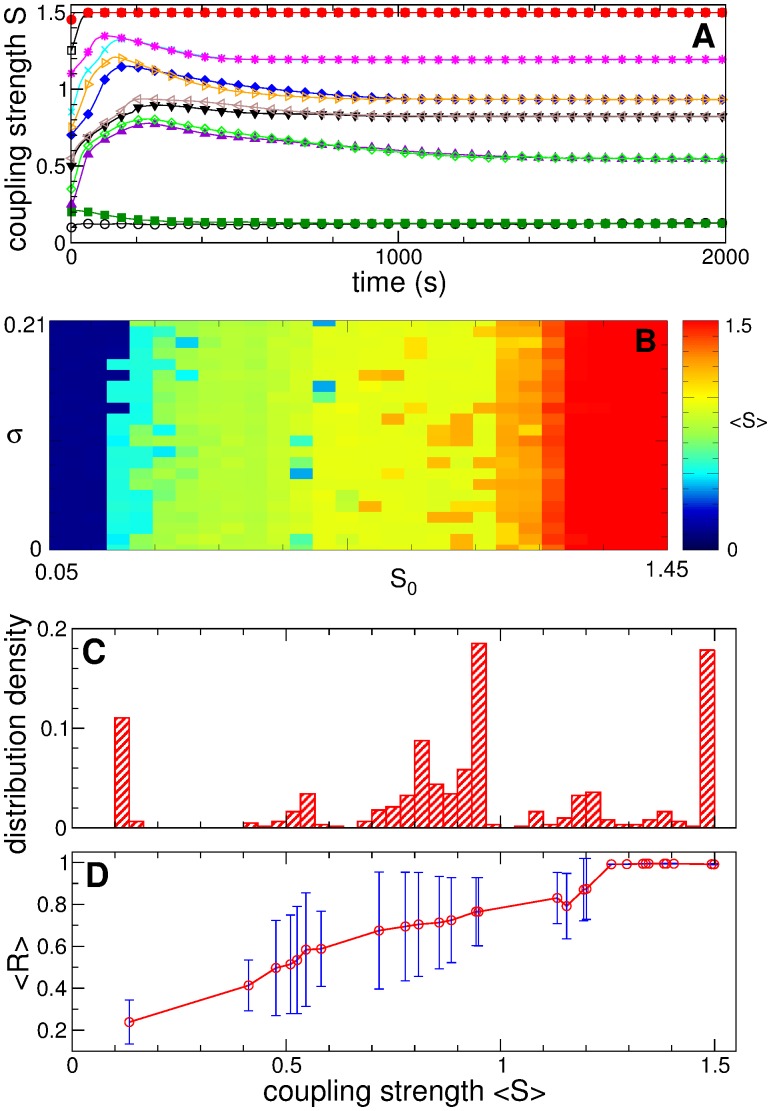
STDP-induced multistability in the neuronal ensemble (1).(A) Time courses of the mean synaptic weight S(t) for 12 different initial conditions selected from the set below. (B) Time-averaged mean synaptic weight 〈S〉 (encoded in color, see attached color bar) realized in the system for a set of 616 different initial conditions. For each initial condition the individual synaptic weights s
ij(0) are uniformly and randomly distributed in the interval [S
0 - σ, S
0 + σ], where S
0 = 0.05 + 0.05k, k = 1,2,…,28, and σ = 0.01m, m = 0,1,…,21. Other variables of ensemble (1) are uniformly and randomly distributed in the interval [-0.1, 0.1]. (C) Histogram of the distribution density of 〈S〉 from plot (B). (D) Time-averaged order parameter 〈R〉 (red circles) and standard deviation of its time fluctuations (error bars) versus the mean synaptic weight 〈S〉 of a few selected regimes established in the ensemble for the initial conditions from plot (B).